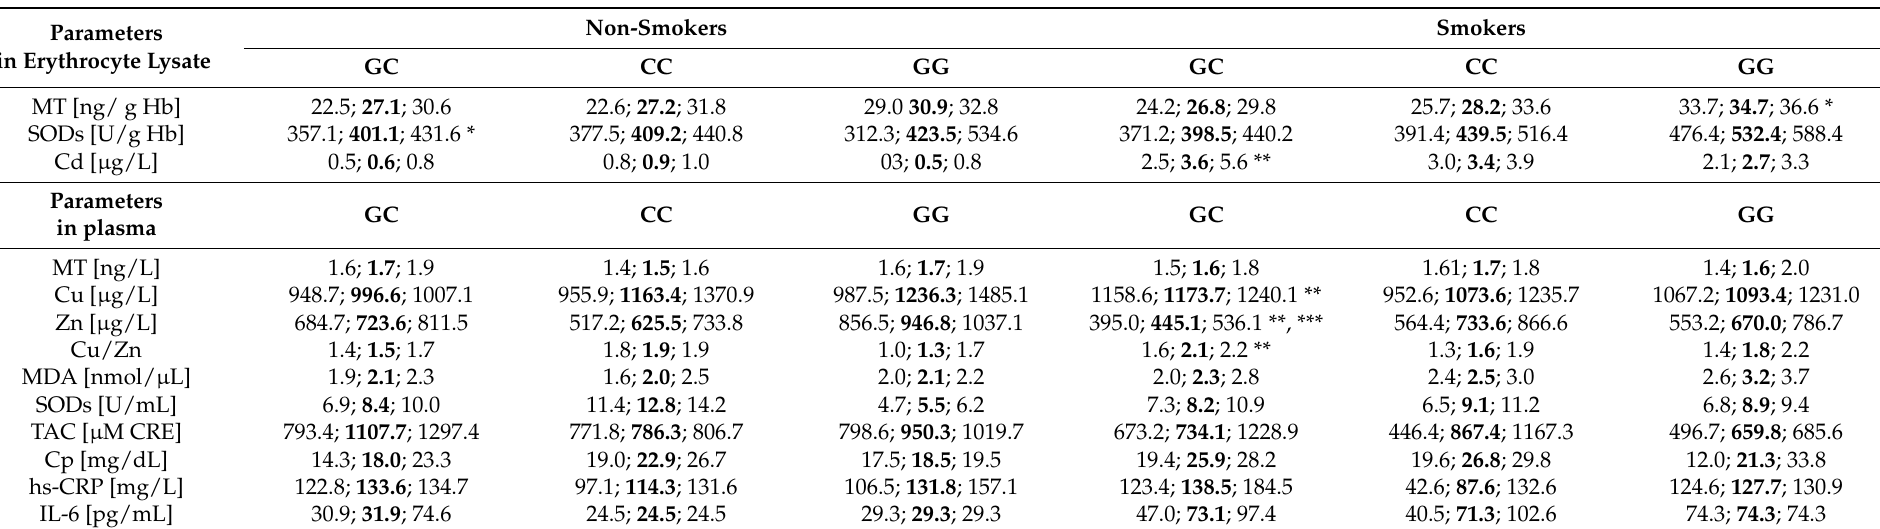
Table 8. The concentration of metals (Cu, Zn and Cd), MT, Cp and markers of inflammation and oxidative stress in the group of non-smoking and smoking patients with AP, with regard to genotypes for rs10636 in the MT2A gene. The bold is to distinguish the median values.